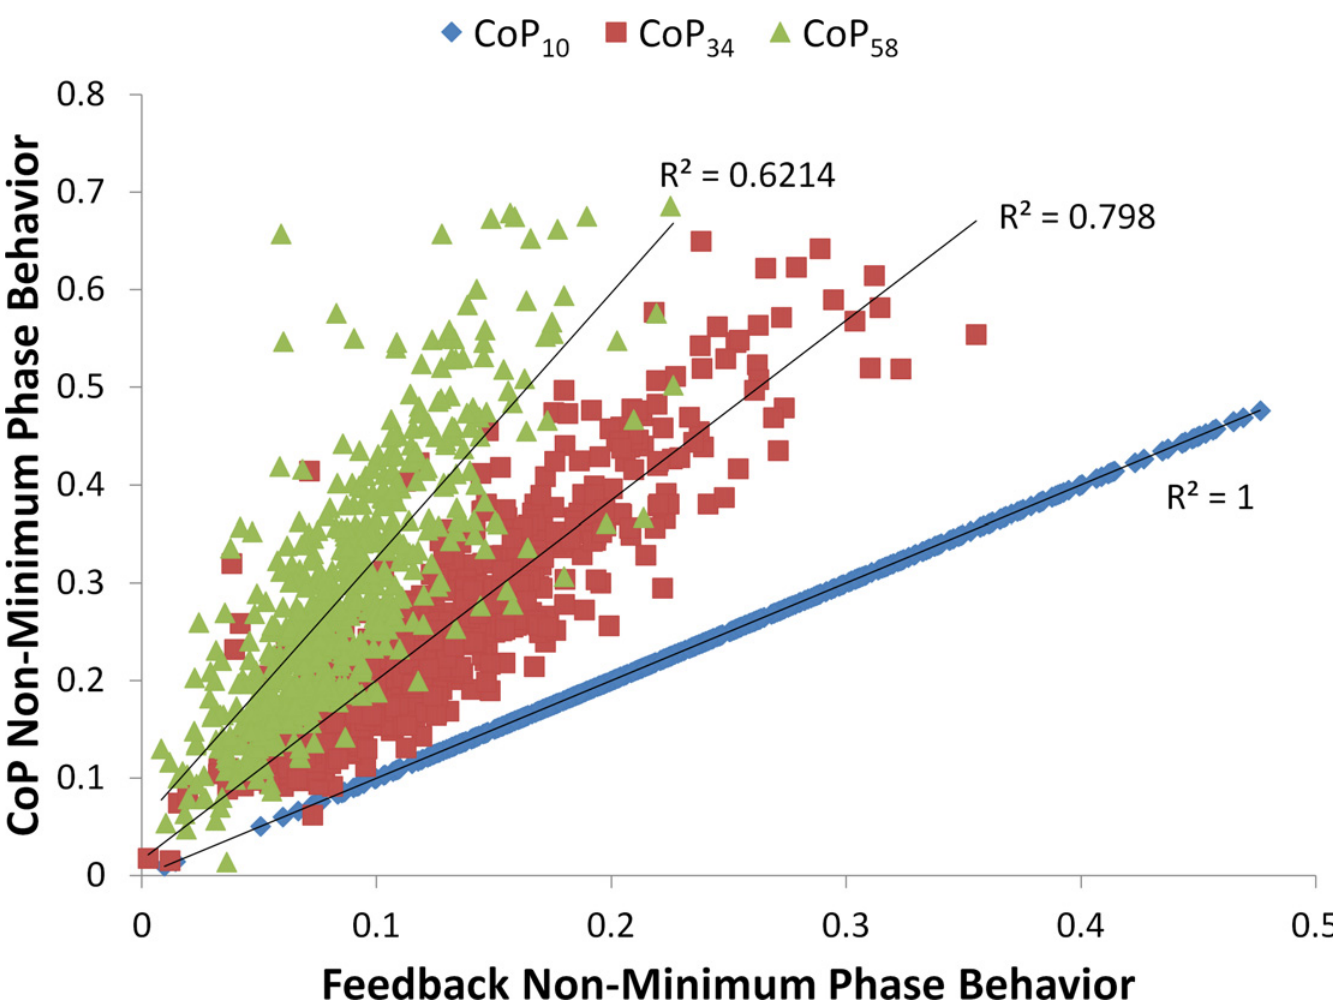
Fig 6. Feedback vs. CoP NMP results. Relationship between feedback NMP behavior and CoP NMP behavior for all three filtered feedback conditions. Trendlines and R 2 values are shown for each feedback